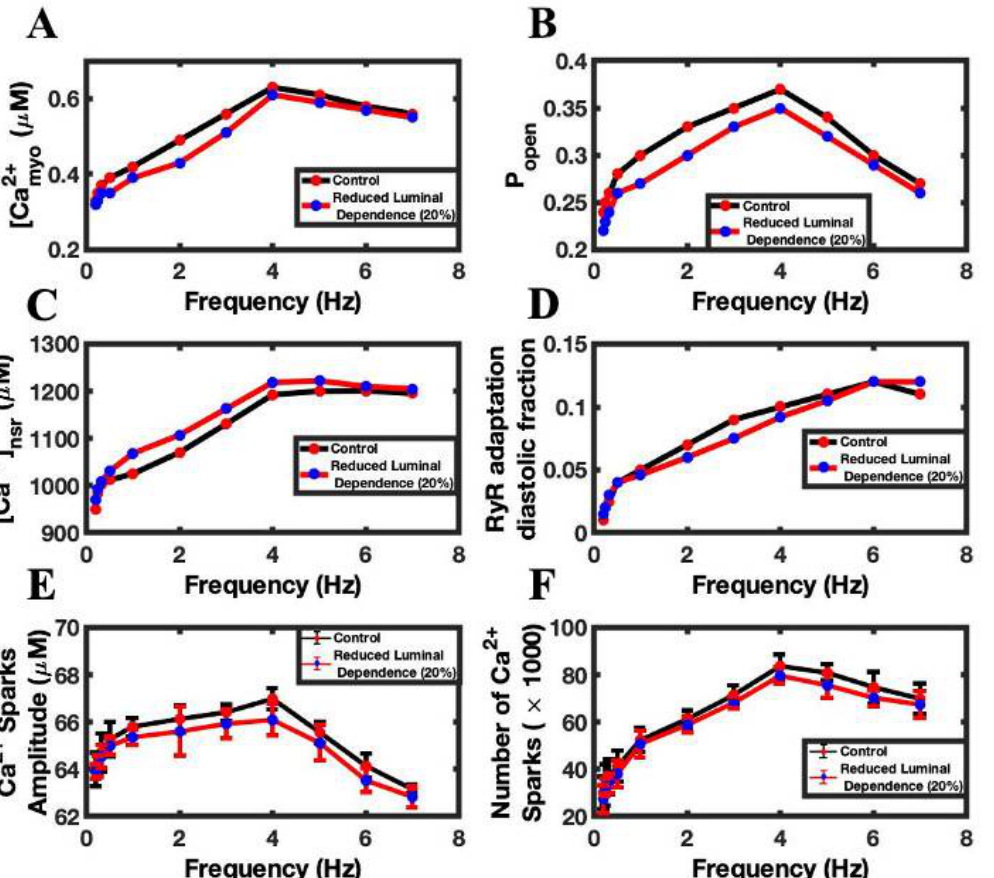
Figure 9. The effects of reducing RyR2 opening rate constant means on frequency-dependent be- haviors. ( A ) Peak myoplasmic Ca 2+ concentration. ( B ) RyR2 open probability. ( C ) Peak NSR Ca 2+ concentration. ( D ) Diastolic fraction of RyR2 in the adapted state. ( E ) Ca 2+ spark amplitude. ( F ) Number of Ca 2+ sparks. Control simulations are shown in black. Simulations with reduced RyR2 activation rate constant are shown in red.